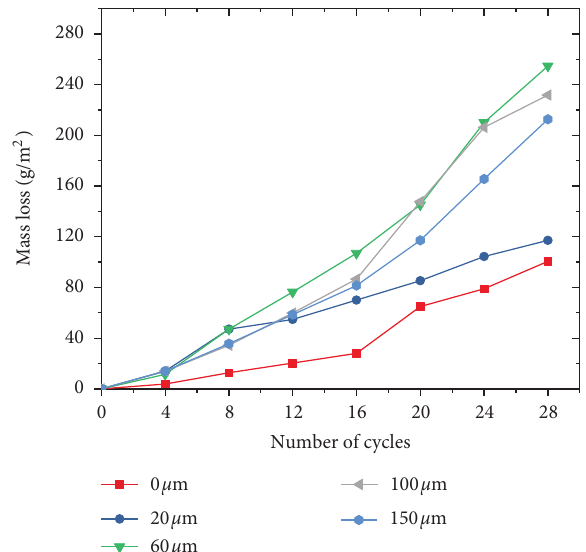
Figure 7: Mass loss of specimens with different salt-freezing cycles.